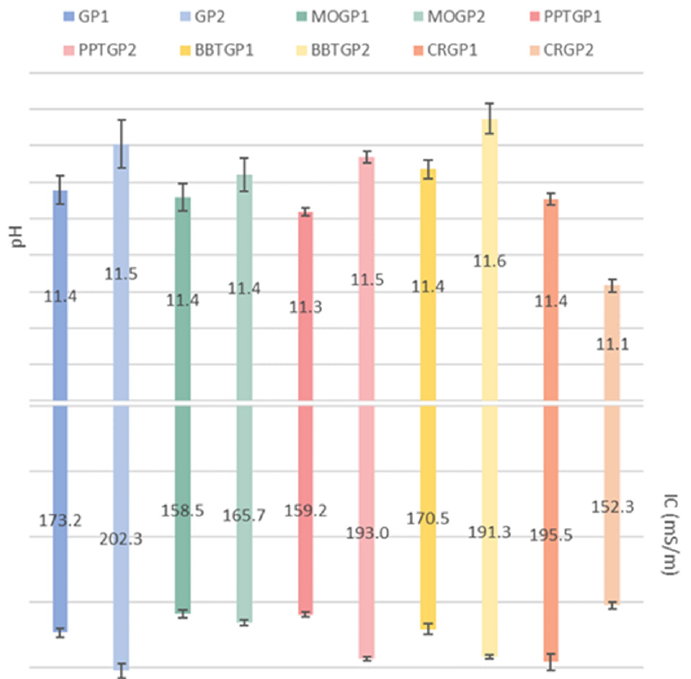
Figure 8. pH and IC values of the eluates obtained after 1 h immersion of the coloured geopolymer samples in water, cured at 25 or 40 °C and tested after 56 days of ageing time.